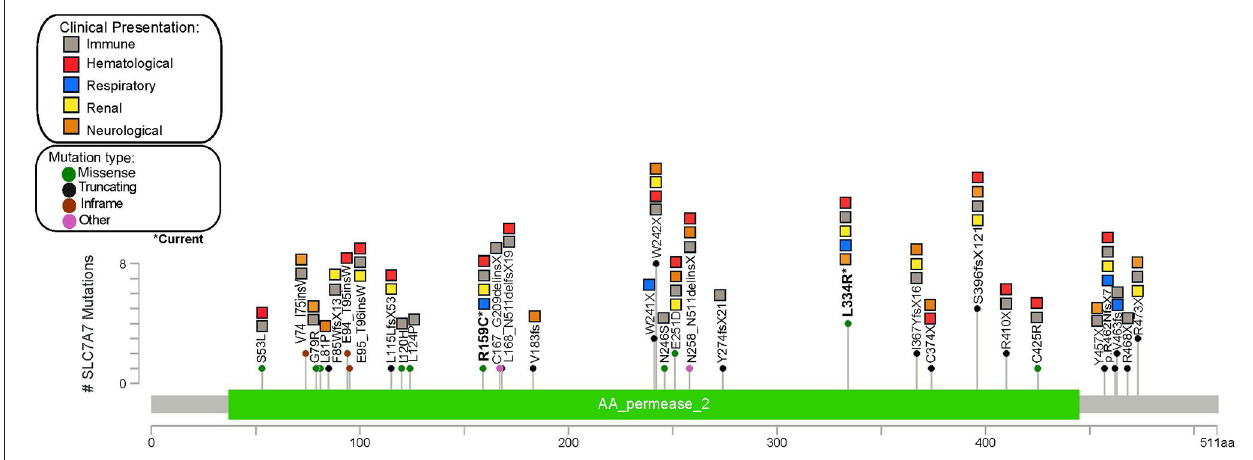
FIGURE 2 | Gene map showing the frequency and clinical manifestations associated with different SLCA7A variants described in the reviewed